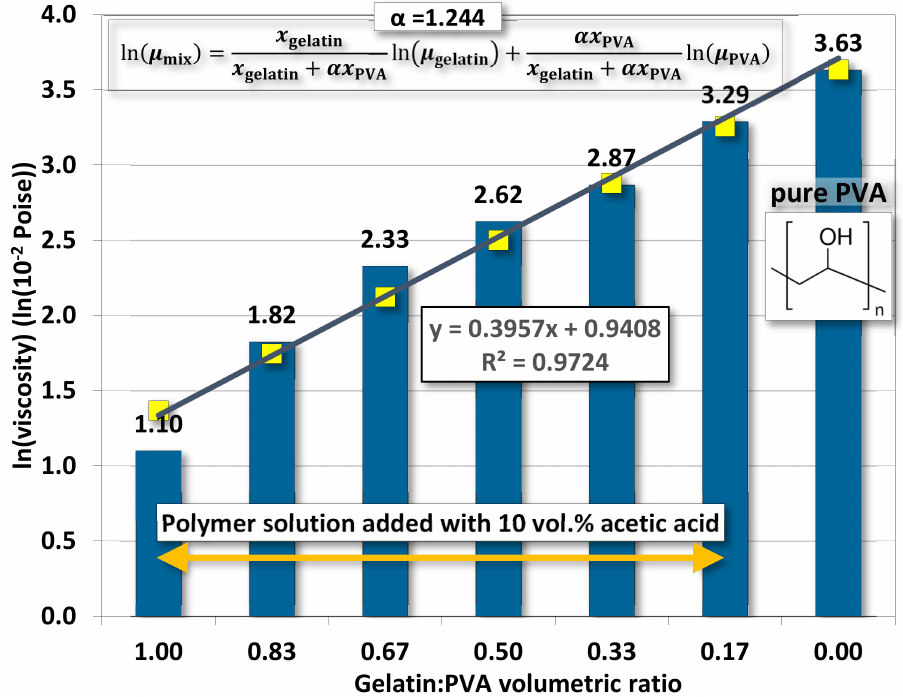
Figure 13. A mixture model for fitting the viscosity of gelatin/PVA mixed solutions. The empirical coefficient α is obtained by minimizing errors in the L 2 norm (square root of the sum of error 2 ) between experimental data and fitting numbers.